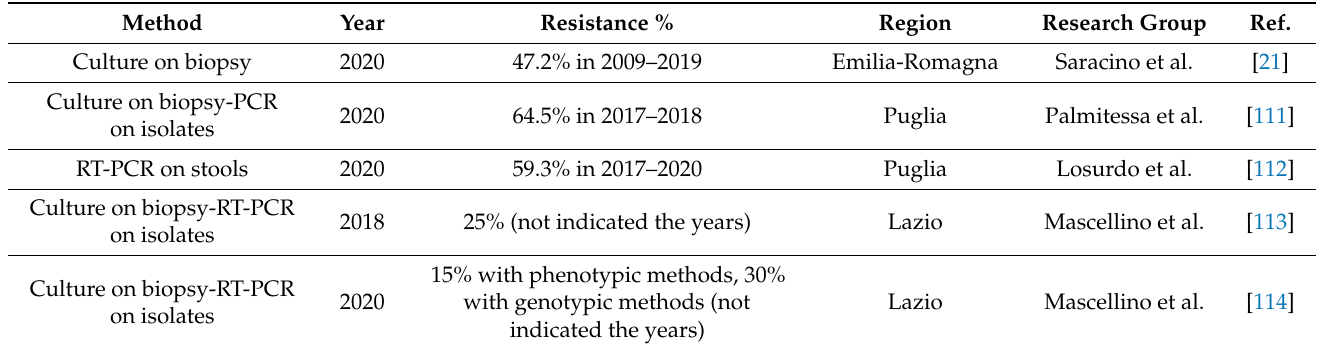
Table 6. Secondary levofloxacin resistance in